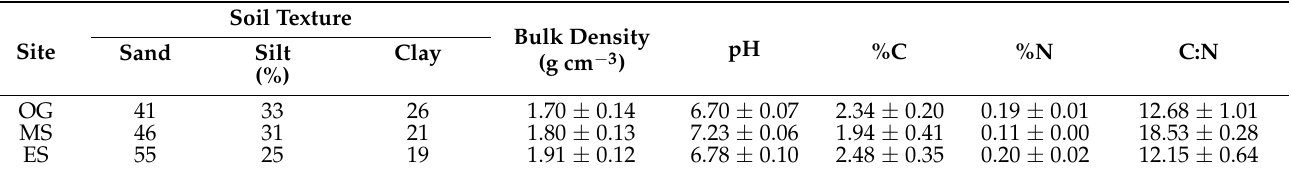
Table 1. Soil physicochemical variables along forest succession from tropical dry forest in northwest- ern Mexico. Data are presented as mean ± standard